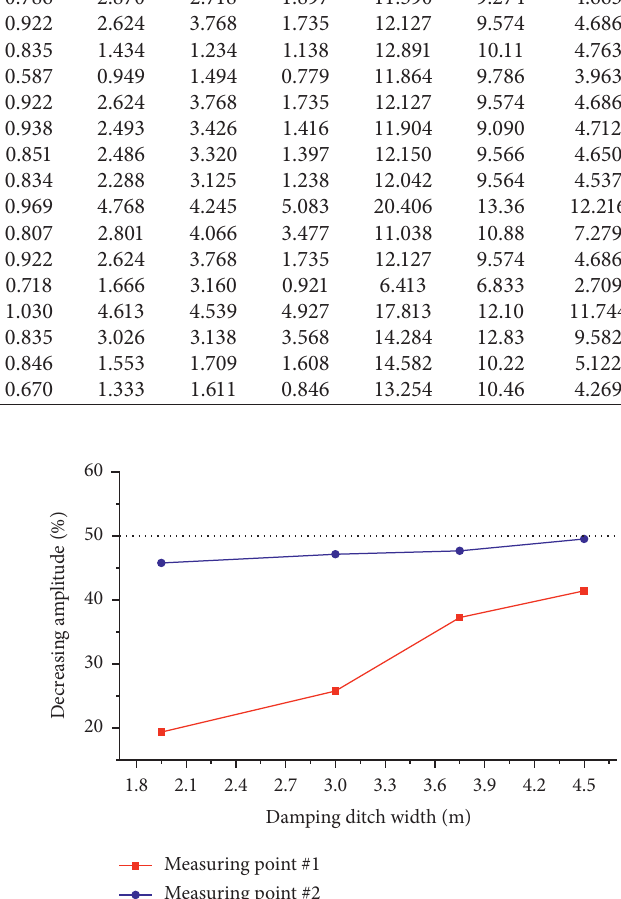
Figure 11: Damping ditch width versus decreasing amplitude.